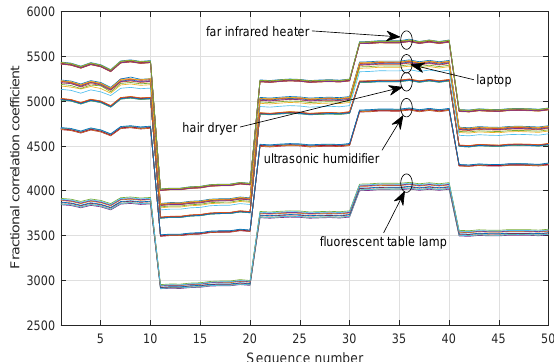
Figure 4. Fractional correlation coefficients for 50 training sequences.